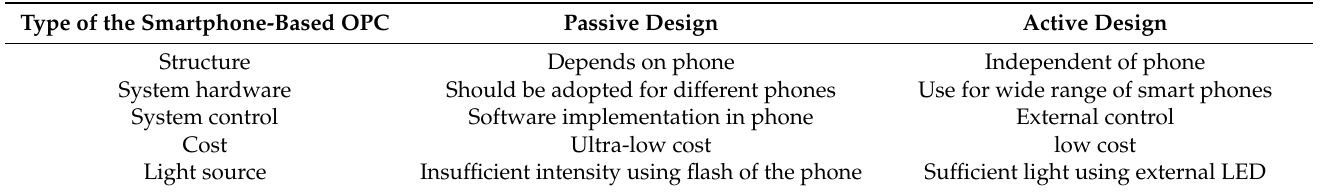
Table 4. Comparing the active and the passive design of the smartphone-based